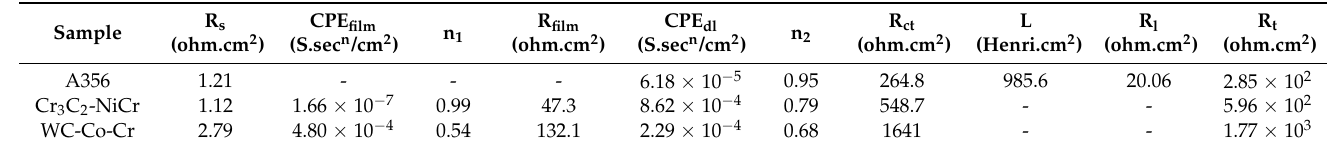
Table 4. The obtained results from the fitting impedance test results on the electrochemical equiva- lent